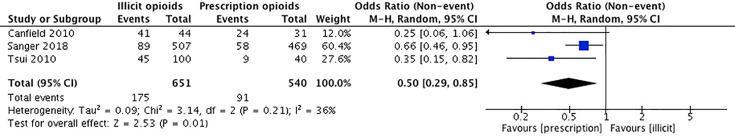
Forest Plot for Cocaine Use.